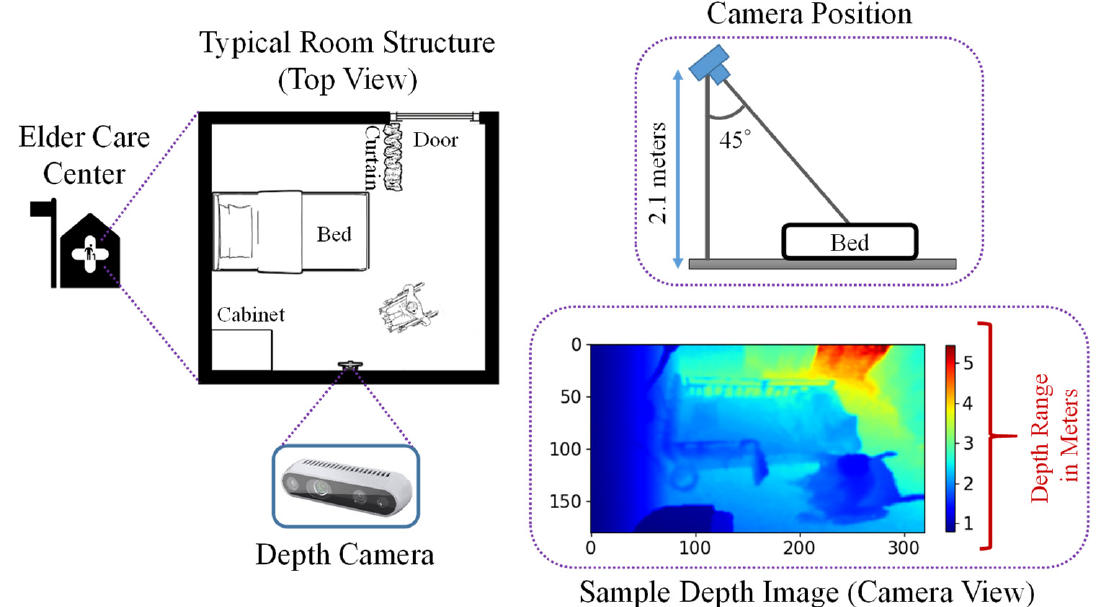
Figure 1. A typical room inside the elder care center, also showing the camera position, and a sample depth image.